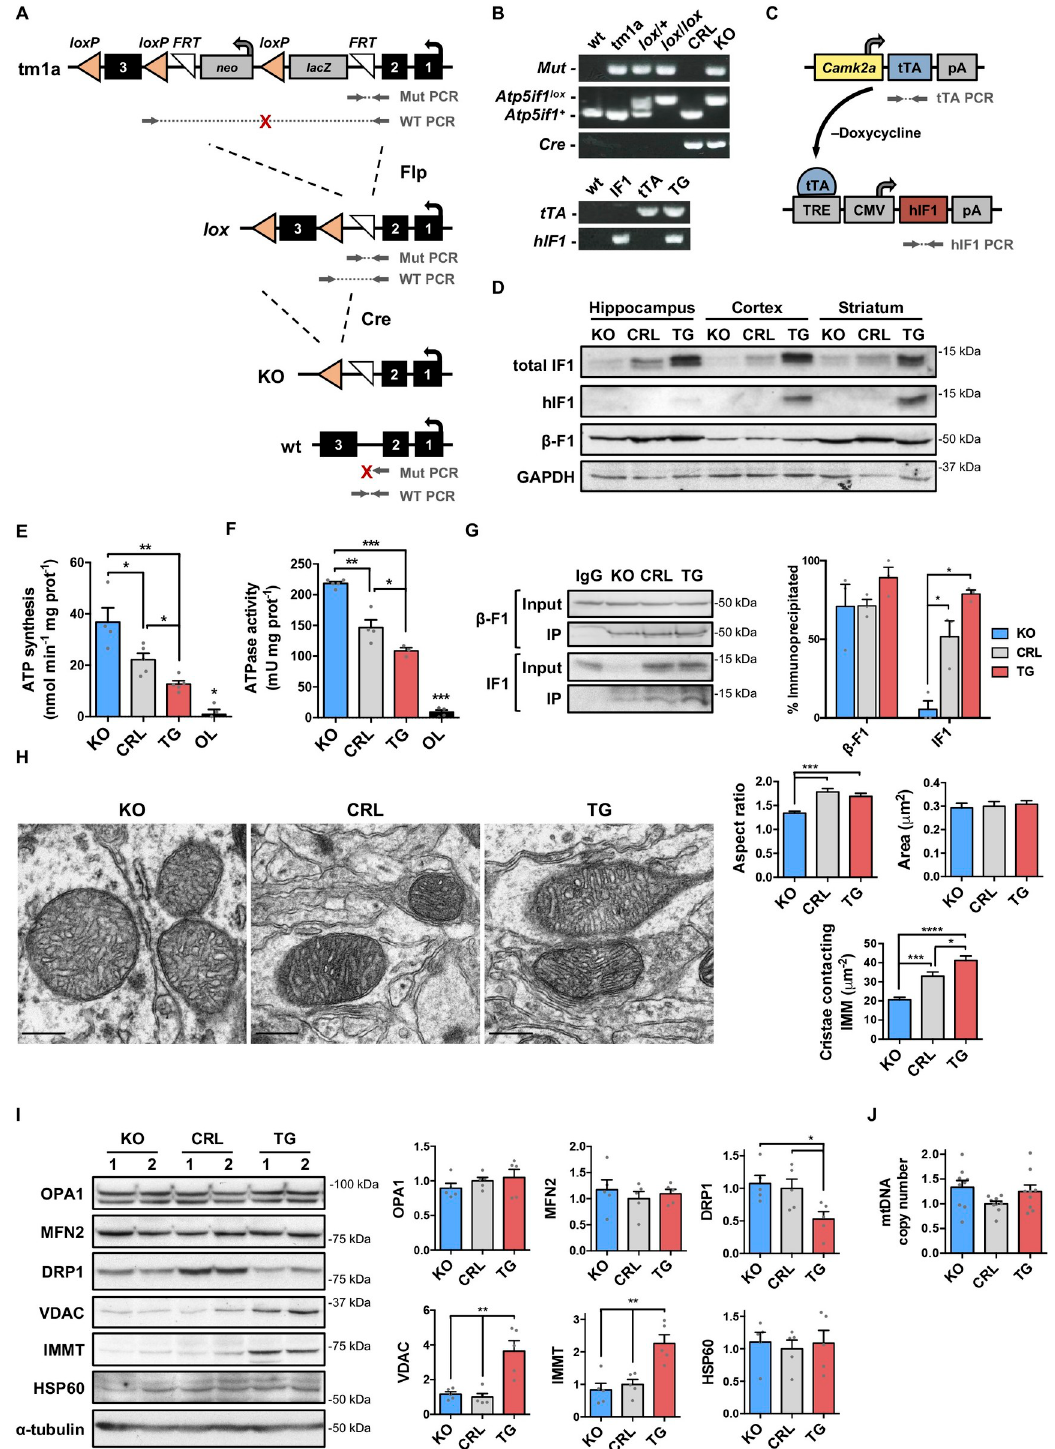
Fig 1. Development of mouse models for the genetic regulation of the ATP synthase in neurons. (A) Generation of IF1 KO mice in neurons showing the Atp5if1 knockout-first (tm1a), floxed ( lox ), KO, and wt alleles. The regions amplified by the PCRs used for genotyping are indicated. Arrows show primers, and red crosses indicate nonproductive PCRs. (B) PCR genotyping of wt, lox , CRL, and IF1 KO mice (upper panel), or wt, IF1, tTA, and IF1 TG mice (lower panel). (C) Schematic of Camk2a-tTA and TRE-hIF1 constructs used to drive hIF1 expression in forebrain neurons in a tetracycline-inducible manner. (D) Western blot of total